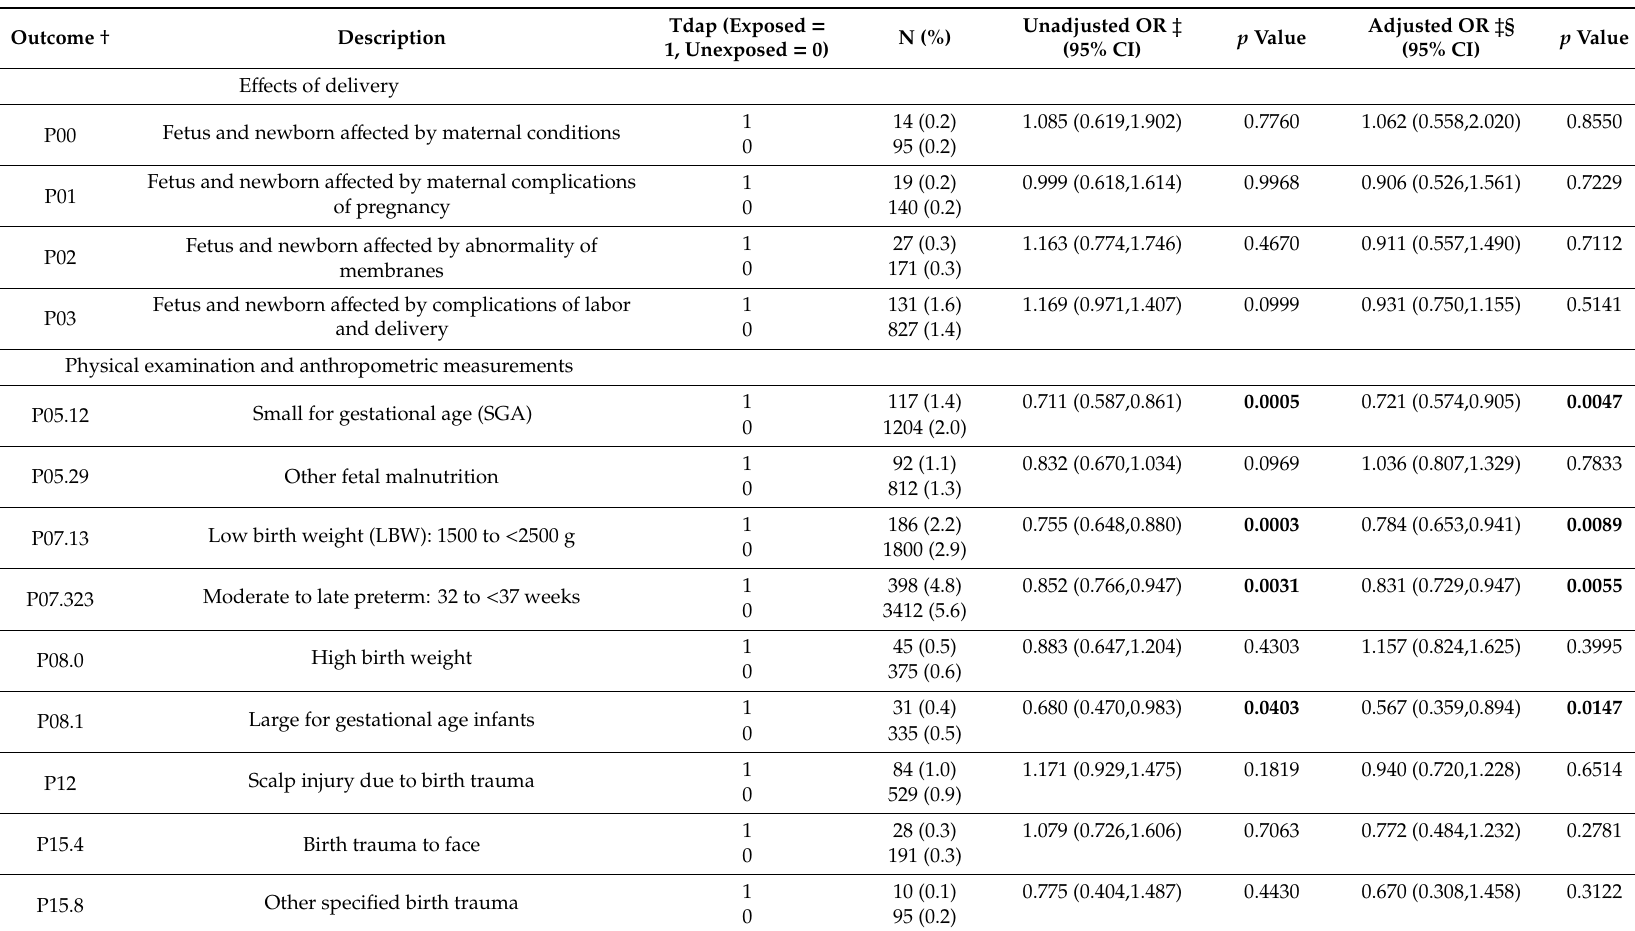
Table 2. E ff ect of maternal Tdap on hospital-related infant outcomes diagnosed at birth, on eligible maternities, * by Tdap exposure, New Zealand (N Exposed = 8299; N Unexposed = 61,090; N Total =